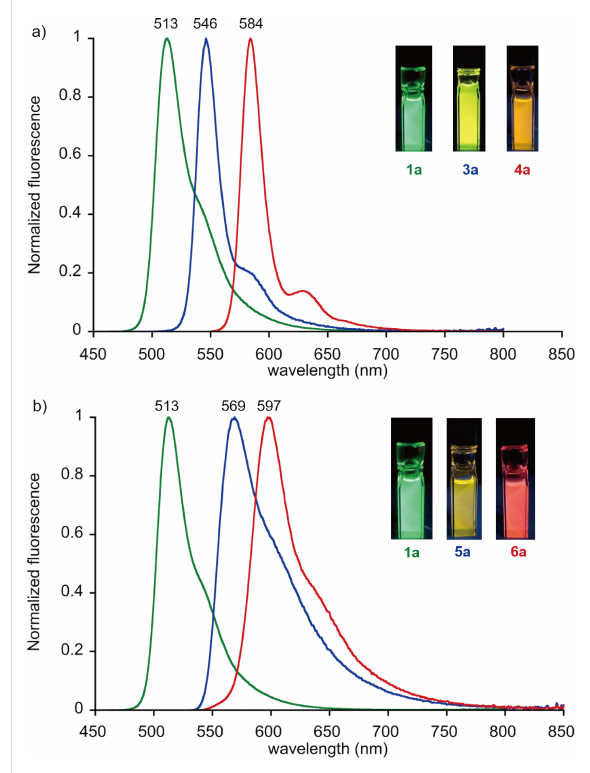
Figure 4: UV–vis absorption spectra of the BODIPY derivatives, (a) 1a (green), 3a (blue), 4a (red), and (b) 1a (green), 5a (blue), 6a (red) in CH 2 Cl 2 . Insets show the photo images of the solutions taken under ambient light.